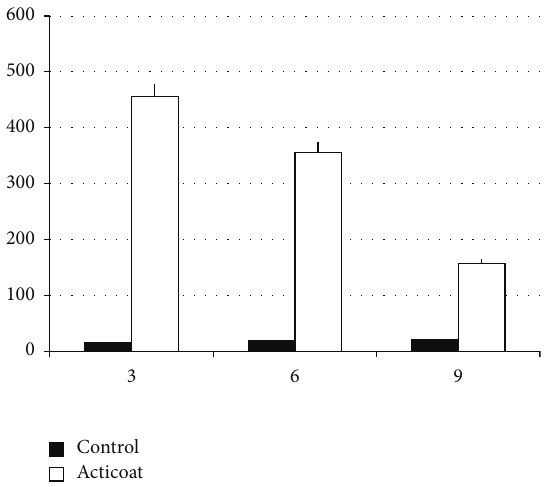
Figure 11: The ROS measurement in dermal-like tissue recon- structed in vitro with (white) and without NgNPs (black) treatment. As it is well evident, when silver nanoparticles are present, ROS activity is